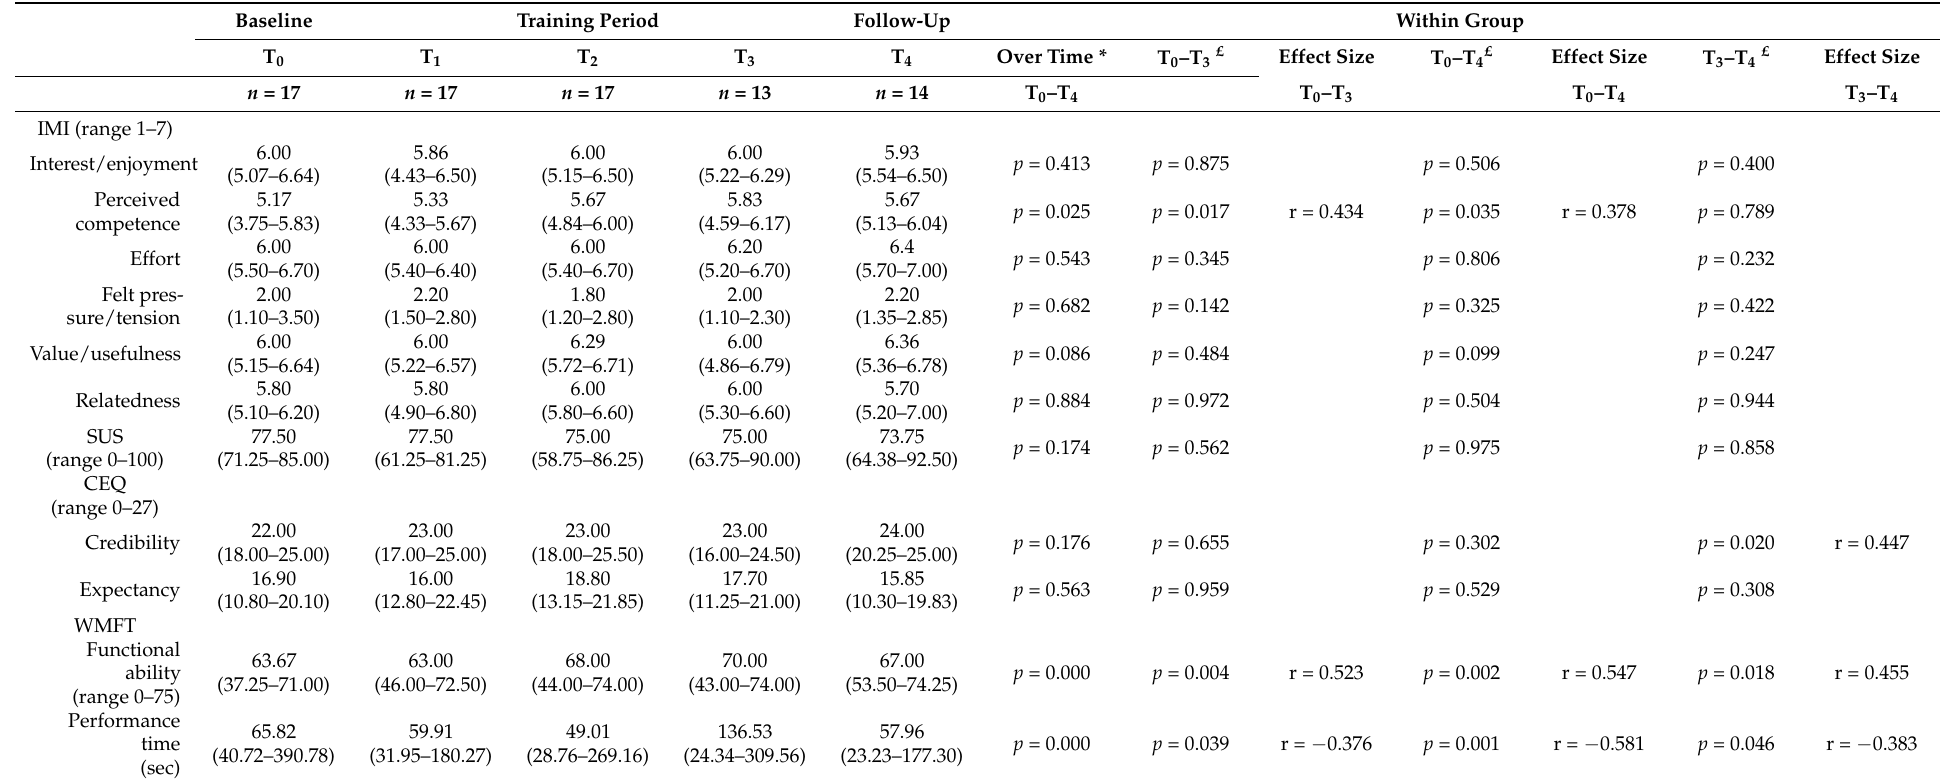
Table 3. Results of all outcome